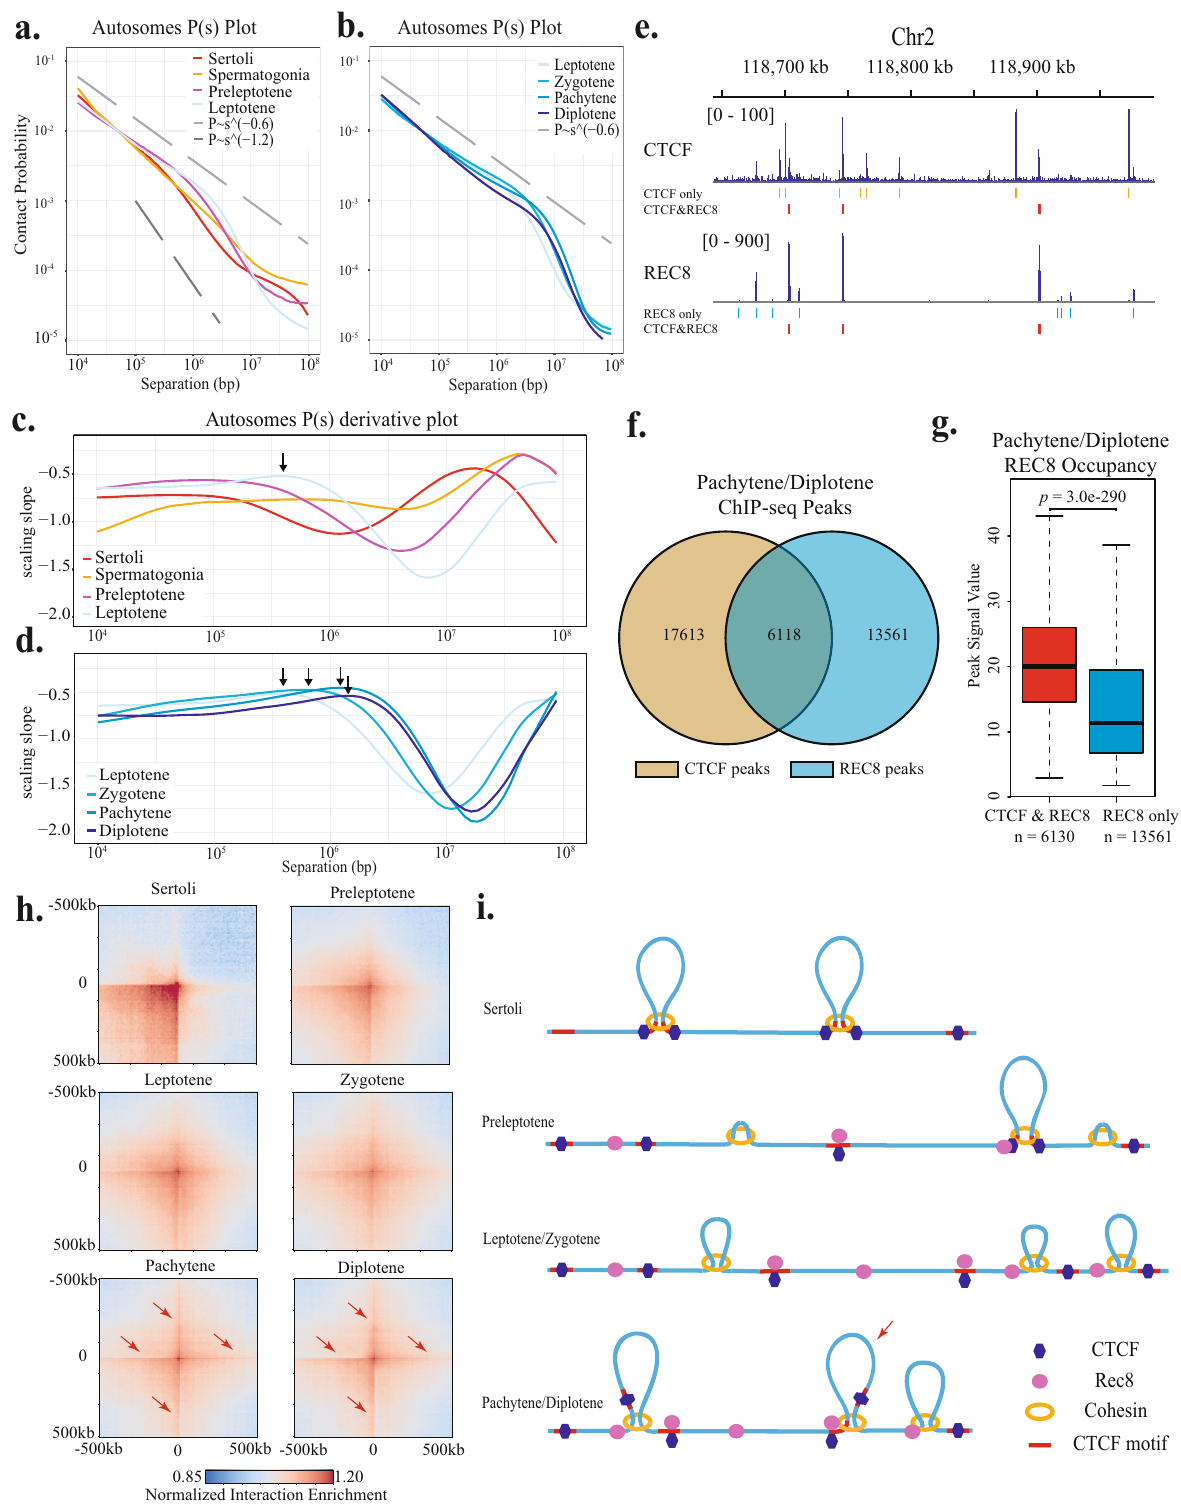
meiosis, its ability to anchor chromatin loops at speci fi c loci and create TAD boundaries was impaired. Tethering chromatin loops to the meiotic chromosome axis does not create strong barriers for loop extension . The pro- gressive extension of meiotic chromatin loops occurs while the